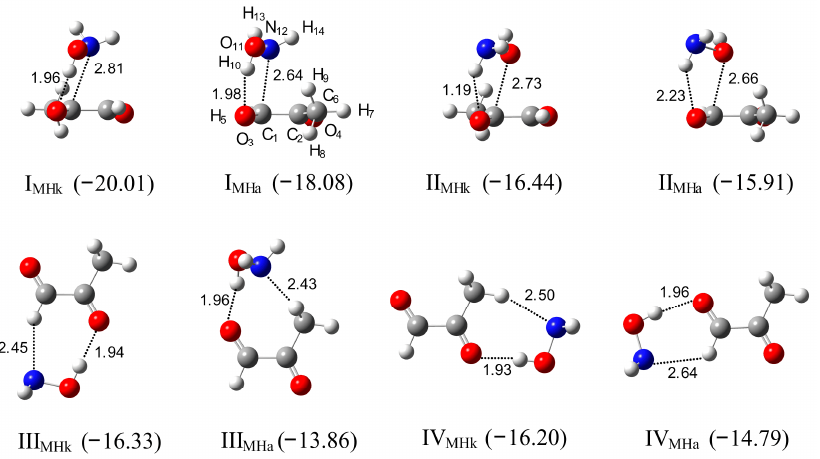
Figure 6. The optimized structures of the CH 3 COCHO–NH 2 OH complexes, I MHk –IV MHk and I M